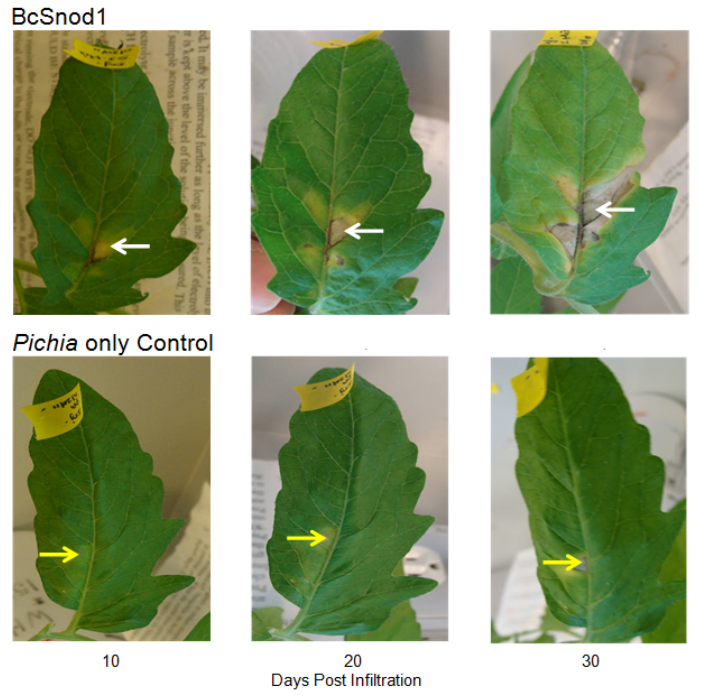
Figure 4. Tomato leaves injected with HPLC purified P. pastoris produced BcSnod1 and the same volume of vector only control. When 15 µg of BcSnod1 were injected (white arrow indicates site of injection), discoloration started within 3 days post infection and continued up to day 10. The entire injected area was necrotized within 15 days and discoloration was observed in adjacent areas. The lower panels indicate leaves injected with pPic9k (control), where slight discoloration is observed after 15 days with minimal necrosis 30 days post-infiltration (yellow arrow indicates site of injection). No spread of discoloration or necrosis in the adjoining regions was